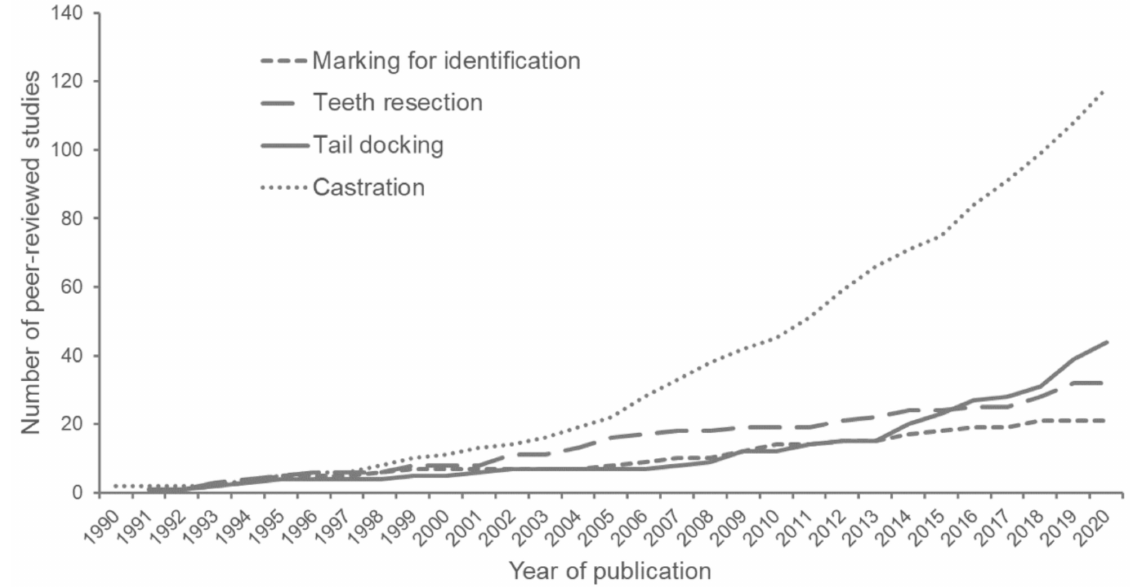
Figure 1. Cumulative number of peer-reviewed studies published between 1990 and 2020 that investigate the effects of identification ( n = 21), teeth resection ( n = 32), tail docking ( n = 44), and castration ( n = 118) on the welfare of suckling piglets. For the sake of completeness, this figure also shows studies that investigated the effects of anesthesia and/or analgesia and were not further discussed in the present review; however, processing studies performed in weaned piglets or adult animals were not